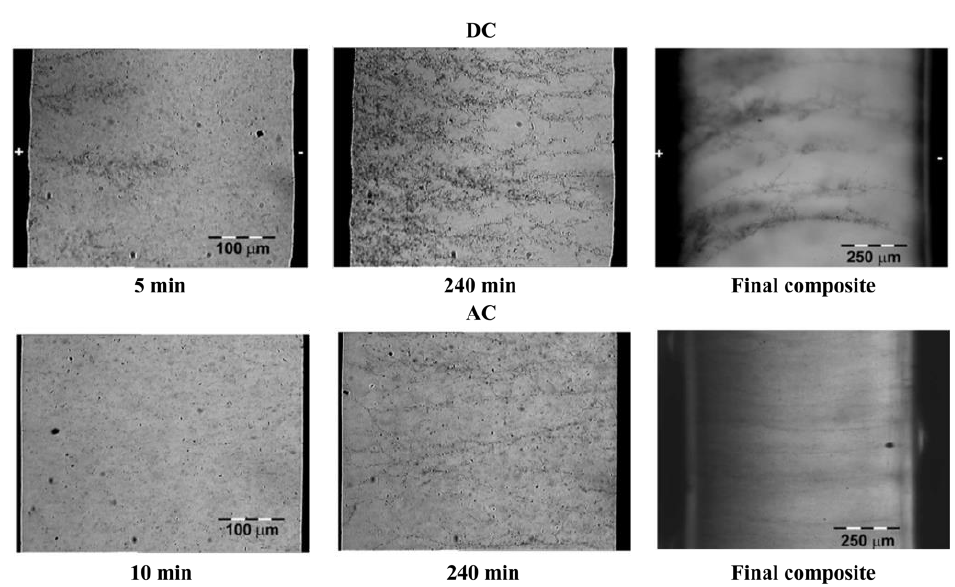
Figure 39. Transmission optical micrographs of epoxy composites containing 0.01 wt.% MWCNTs during curing at 80 °C using a DC and AC of 100 V/cm. Reprinted from [112], Copyright 2005, with permission from Elsevier.